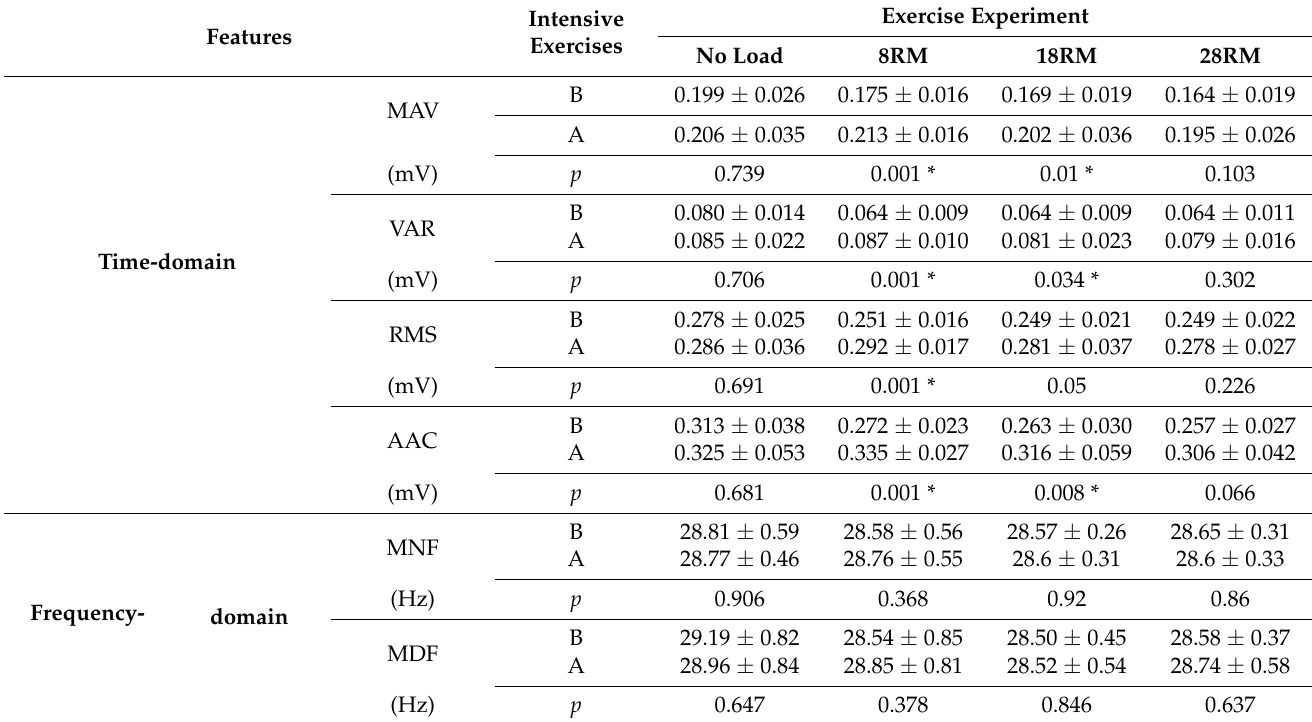
Table 2. Statistical analysis of EMG features in exercise experiment (Mean ± SD).